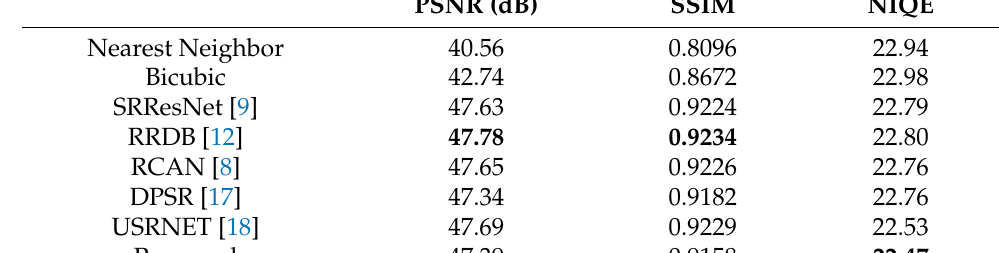
Table 2. Comparison between the difference methods under upscale factor ×2 on KOMPSAT-3 dataset. (The bold values are the best among all the methods).